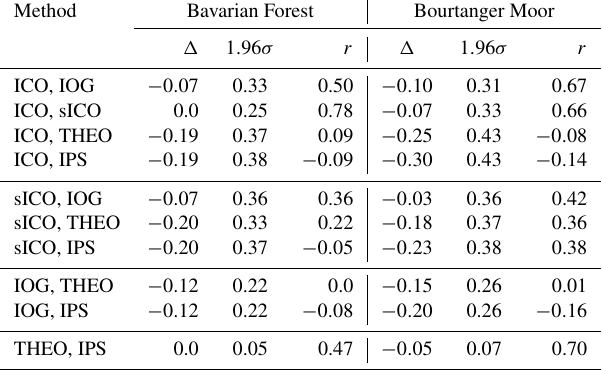
Table B1. Result of the comparison between different damping de- termination methods at the two measurement sites. Bias ((cid:49)) is com- puted as the averaged difference between α values. Precision is given as 1.96 standard deviation of the difference. r is the corre- lation coefficient.